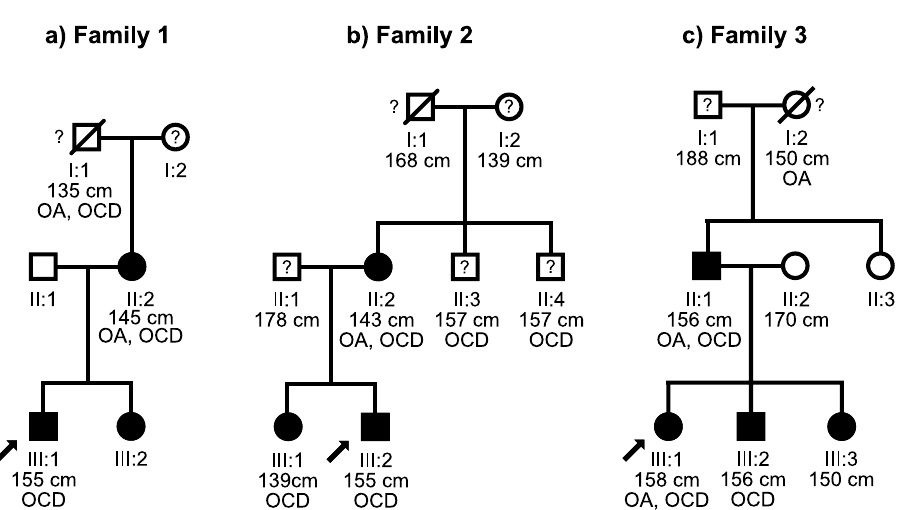
Figure 3. Pedigrees of the studied families. Pedigrees are shown for ( a ) Family 1, from Australia, ( b ) Family 2, from the United Kingdom, and ( c ) Family 3, from New York, USA. The probands are identified by arrows. Filled symbols indicate individuals with heterozygous ACAN gene variants verified by DNA sequencing, question marks indicate no sequence information is available for the individual. The height and diagnosed osteoarthritis (OA) or osteochondritis dissecans (OCD) are indicated below